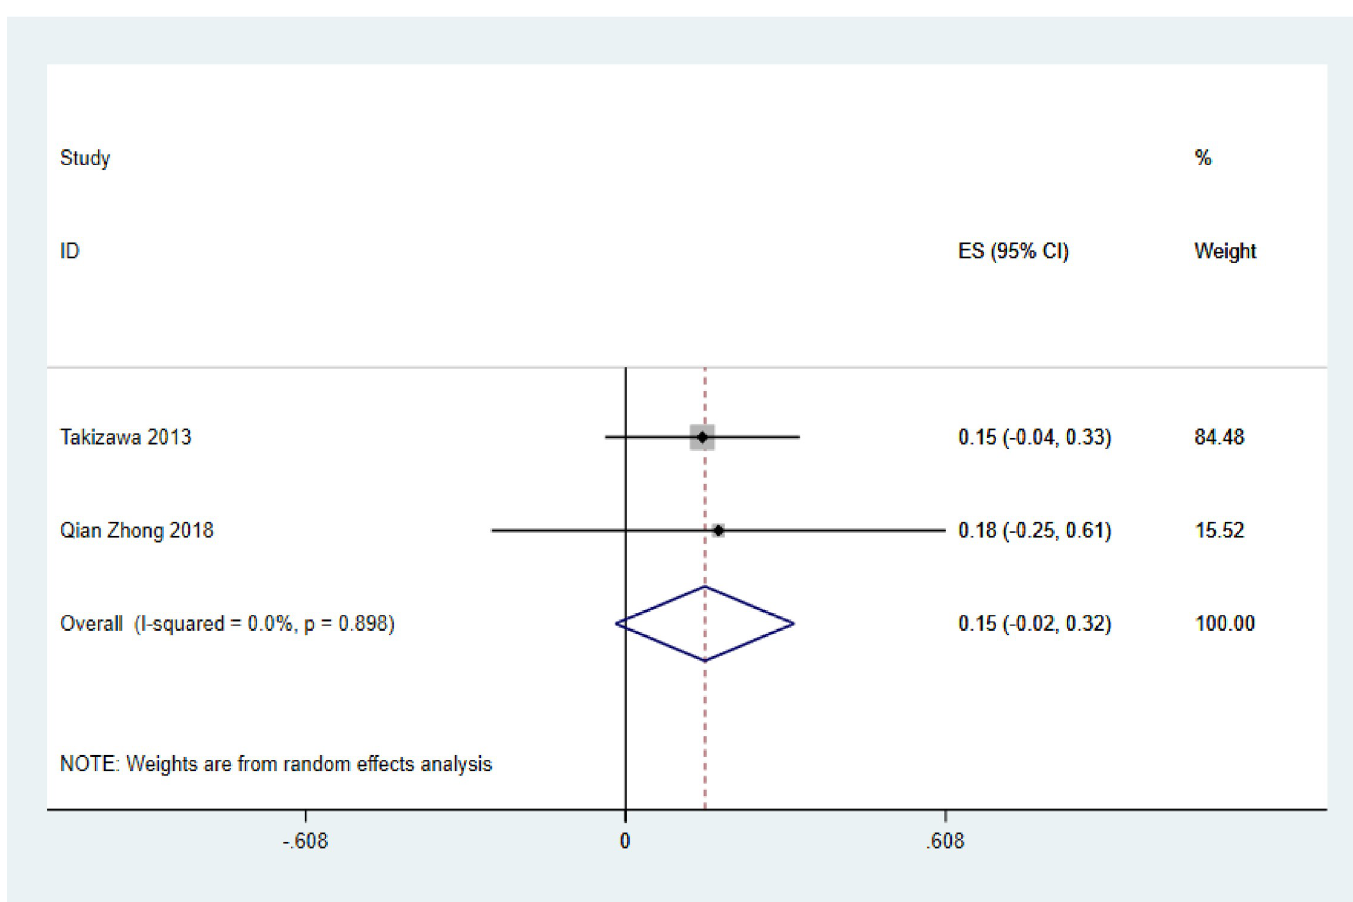
Fig 3. The rate of LNM in mixed-type intramucosal gastric